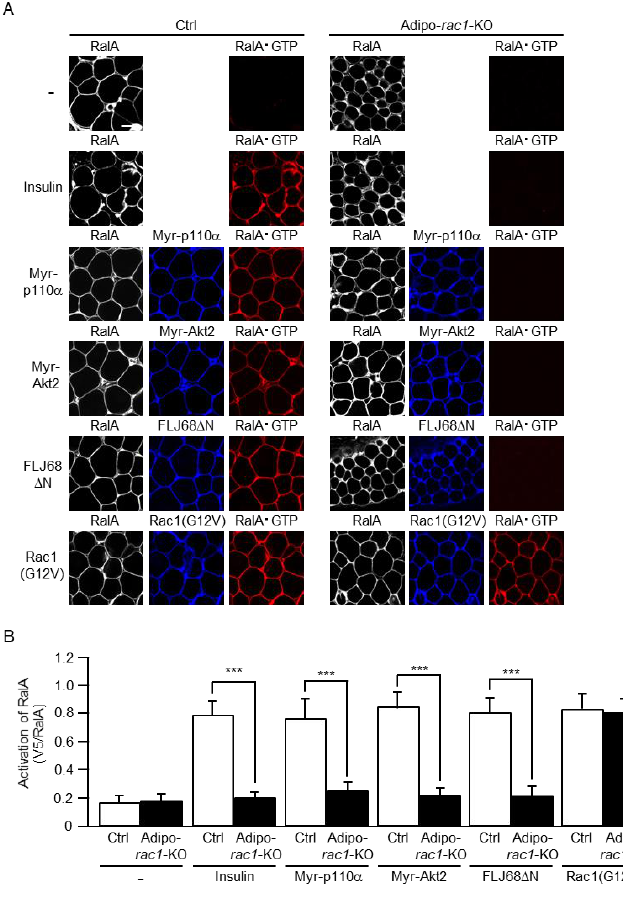
Figure 7. Inhibition of the activation of RalA induced by insulin or a constitutively activated mutant of PI3K, Akt2, or FLJ00068 in rac1 -KO sWAT. ( A ) Endogenous RalA was visualized by immunofluorescent microscopy using an anti-RalA antibody. Myr-p110α, Myr-Akt2, FLJ68ΔN, and Rac1(G12V) were visualized by immunofluorescent microscopy using an anti-HA antibody. RalA · GTP was visualized by immunofluorescent microscopy using the activation-specific probe GST-V5 × 3-Sec5(1–99) and an anti-V5 antibody. Scale bar, 50 µ m. ( B ) The activation of RalA shown in ( A ) was quantified. Data are shown as means ± S.E. ( n = 15). *** p <